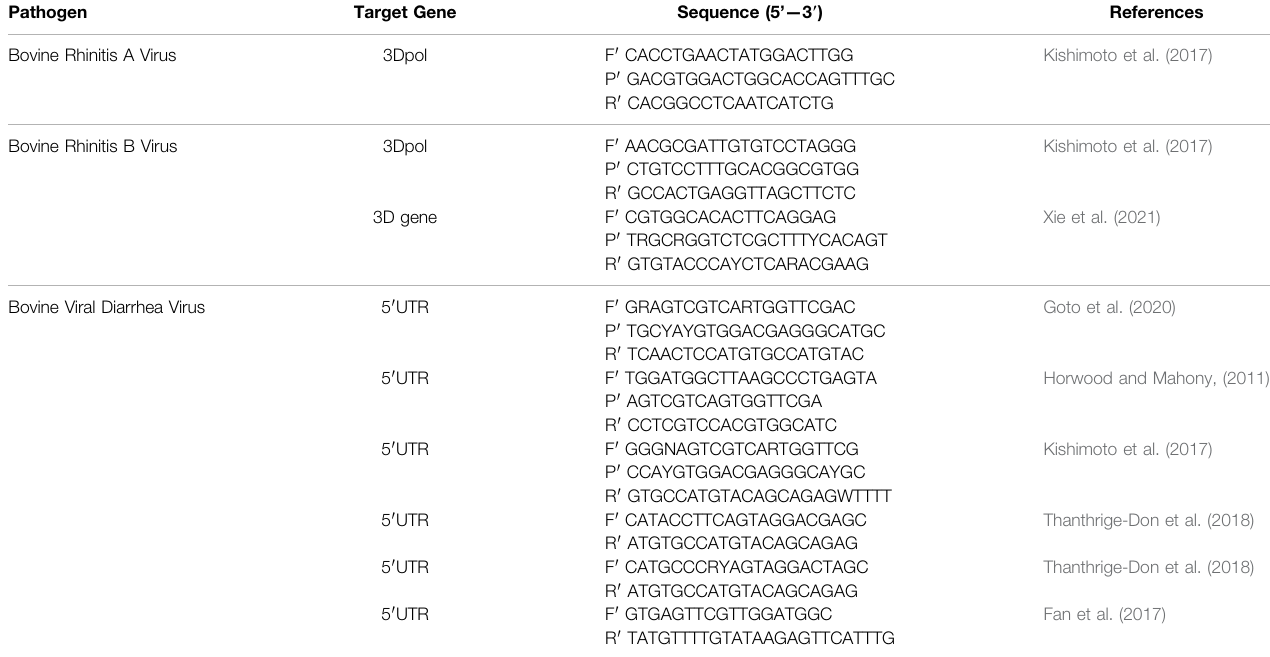
TABLE5| ContinuedPublishedPCRprimerandprobesequencesfordetectionofviralpathogensassociatedwithbovinerespiratorydiseasecomplex.F ′ forward;P ′ probe, R ’ reverse